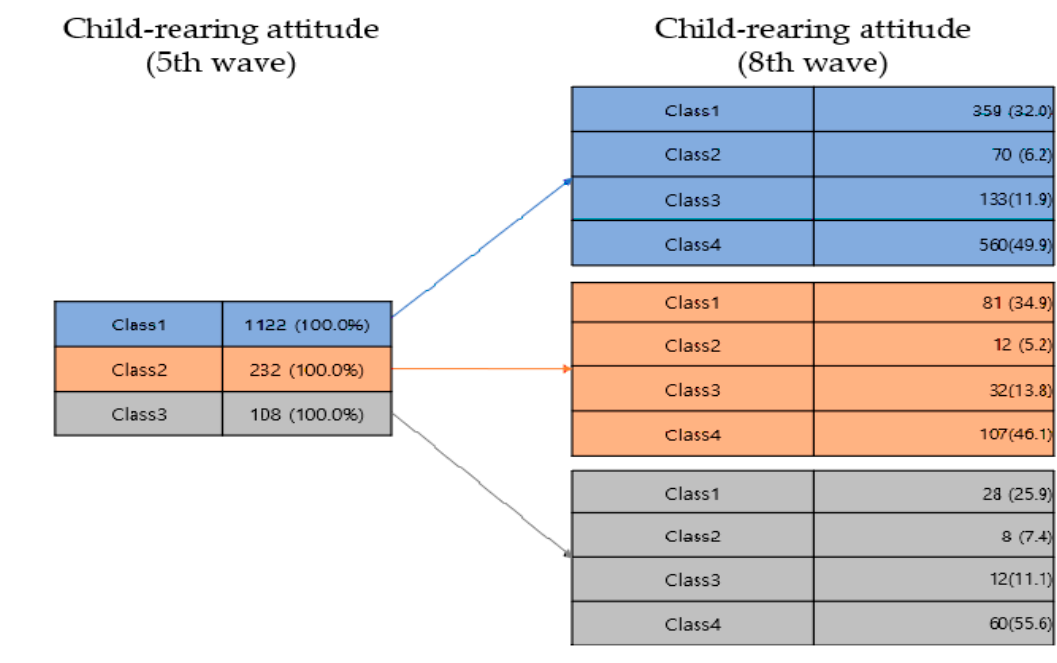
Figure 3. Transition analysis of child-rearing attitude.